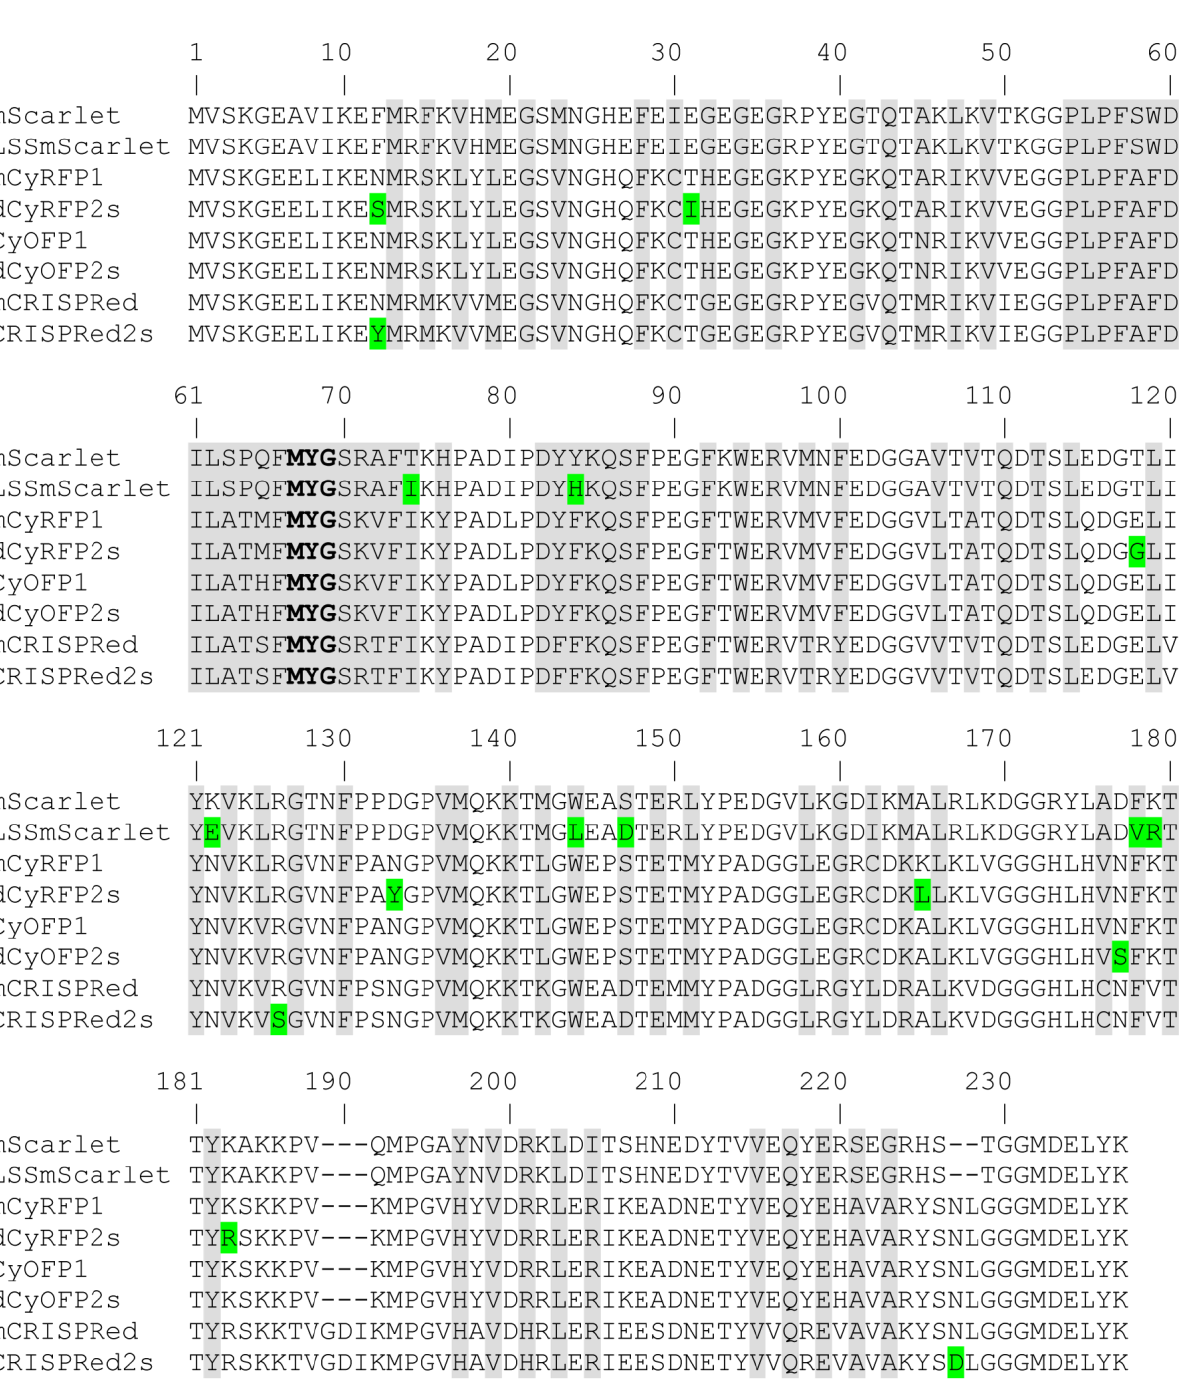
Figure 1. Alignment of the amino acid sequences for the developed LSSRFPs (LSSmScarlet, dCyRFP2s and dCyOFP2s) and their progenitors (mScarlet, mCyRFP1 and CyOFP1). Mutations in the developed LSSRFPs are highlighted in green color. Chromophore-forming residues MYG are selected in bold. Residues buried in the β -barrel are in grey.